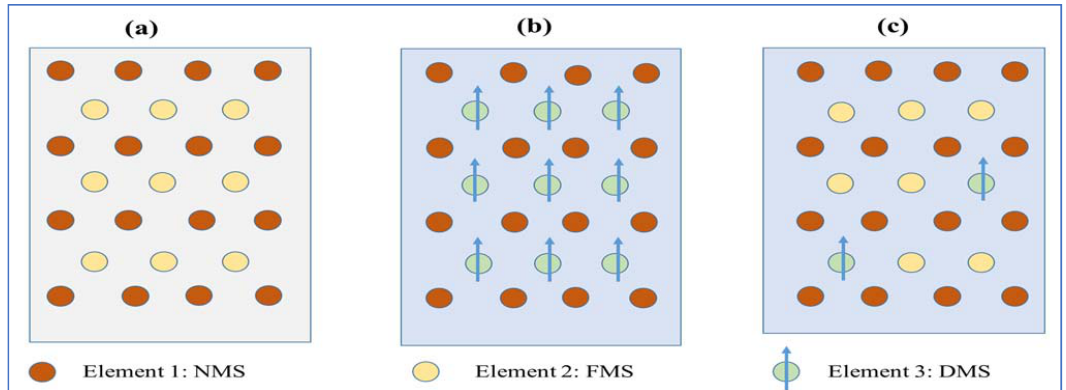
Figure 2. Three types of semiconductors: ( a ) Non ‐ magnetic semiconductor (NMS), ( b ) ferromagnetic semiconductor (FMS): addition of magnetic transition metal ions in a non ‐ magnetic semiconductor where arrows represent domain with orientated spin polarization and ( c ) dilute magnetic semiconductor on introduction of a small fraction of magnetic transition metal ions.